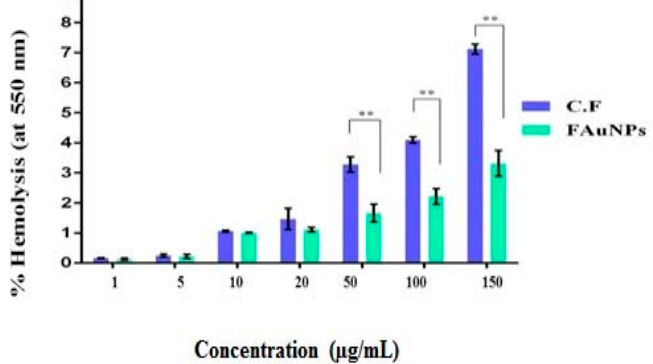
Figure 8. Hemolytic activity of CF and FAuNPs. ** p < 0.01.